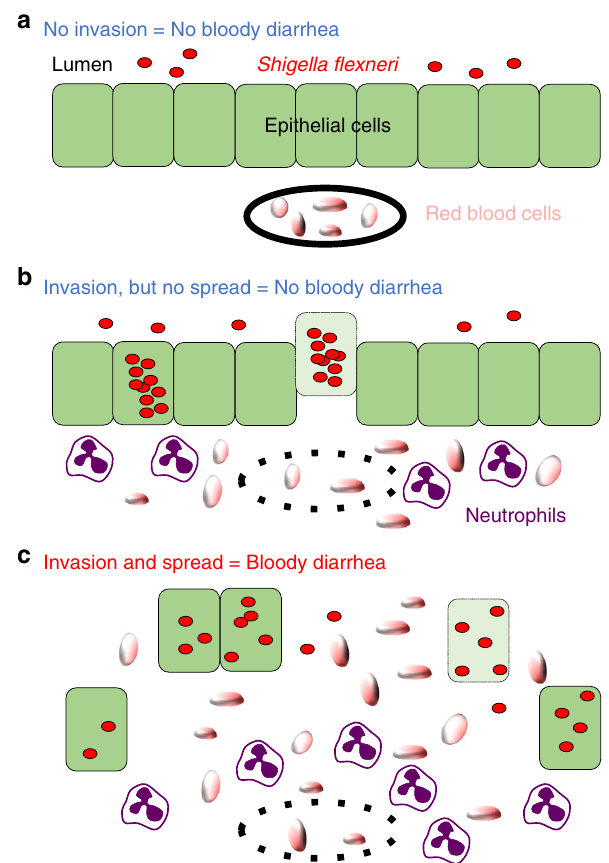
Fig. 7 Model of bacillary dysentery. a In the absence of intracellular invasion (i.e. Δ T3SS mutant) of epithelial cells (green), S. fl exneri (red) is present in the lumen, and red blood cells (tangerine) are con fi ned to blood vessels (black line). Infected animals do not display any symptoms (no bloody diarrhea). b In the absence of cell-to-cell spread (i.e., Δ icsA mutant),